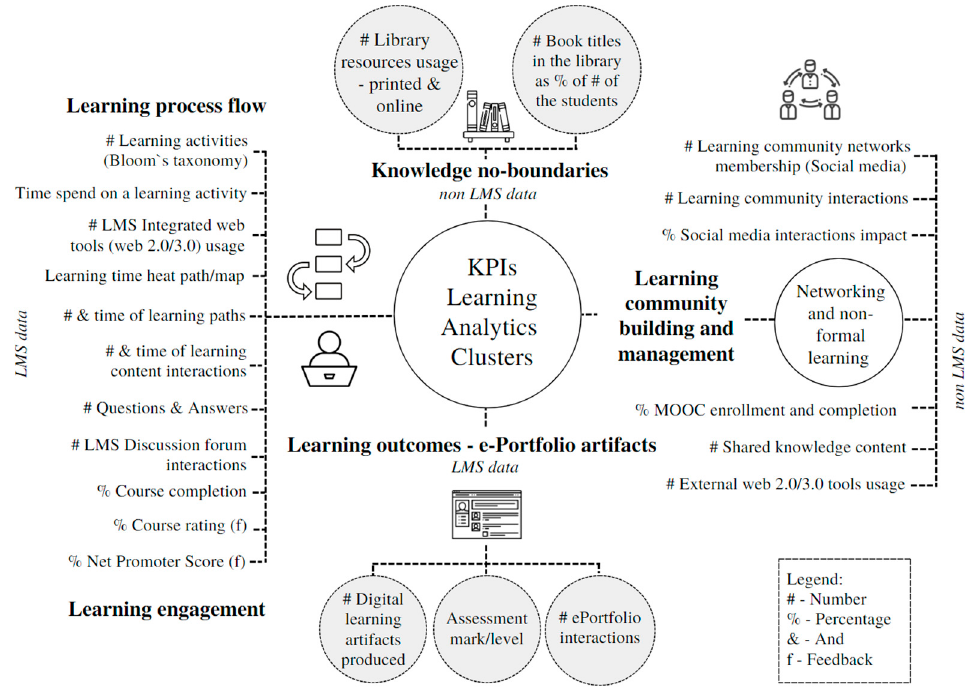
Figure 7. Learning Analytics KPIs Four-Clusters model.